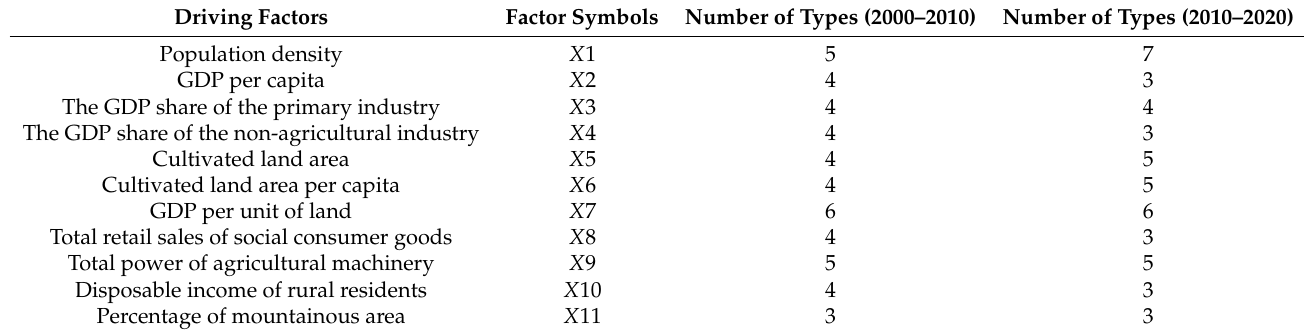
Table 2. Driving factors and number of discretization